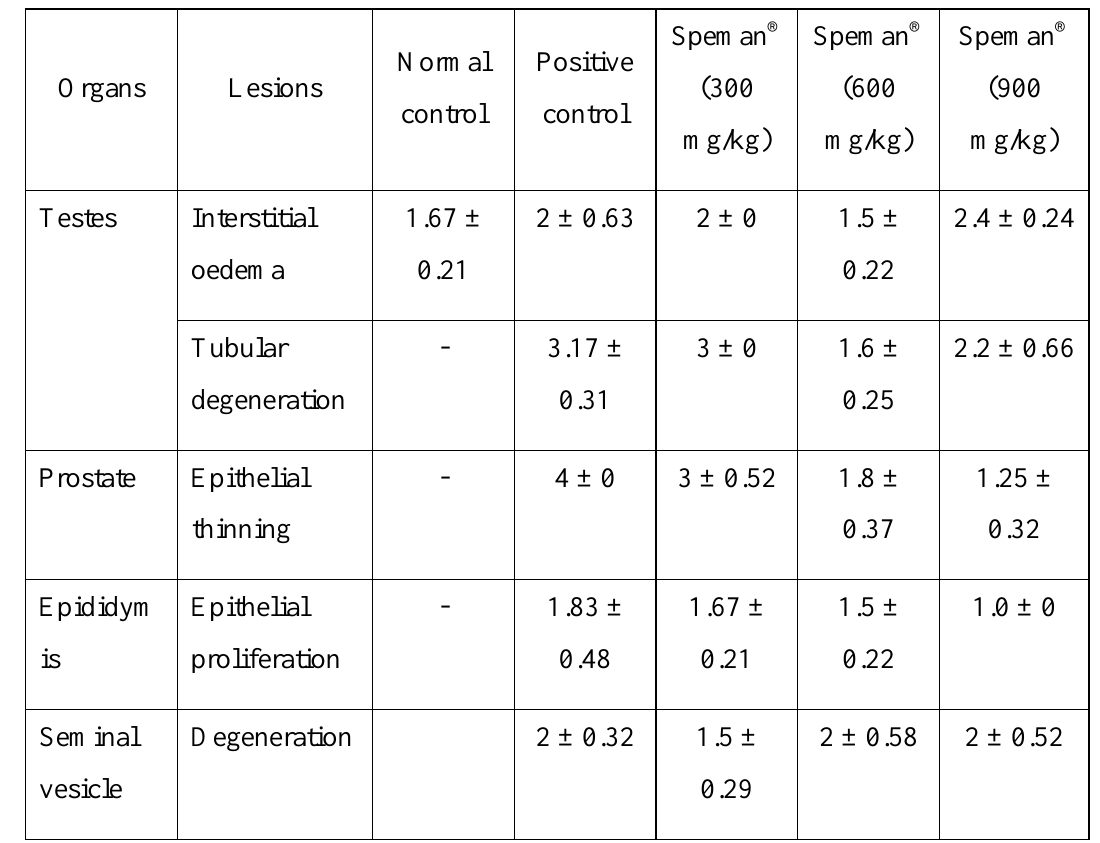
Table 1: Results of the histopathological evaluation of the accessory reproductive organs following Speman ® treatment in rats with CP-induced